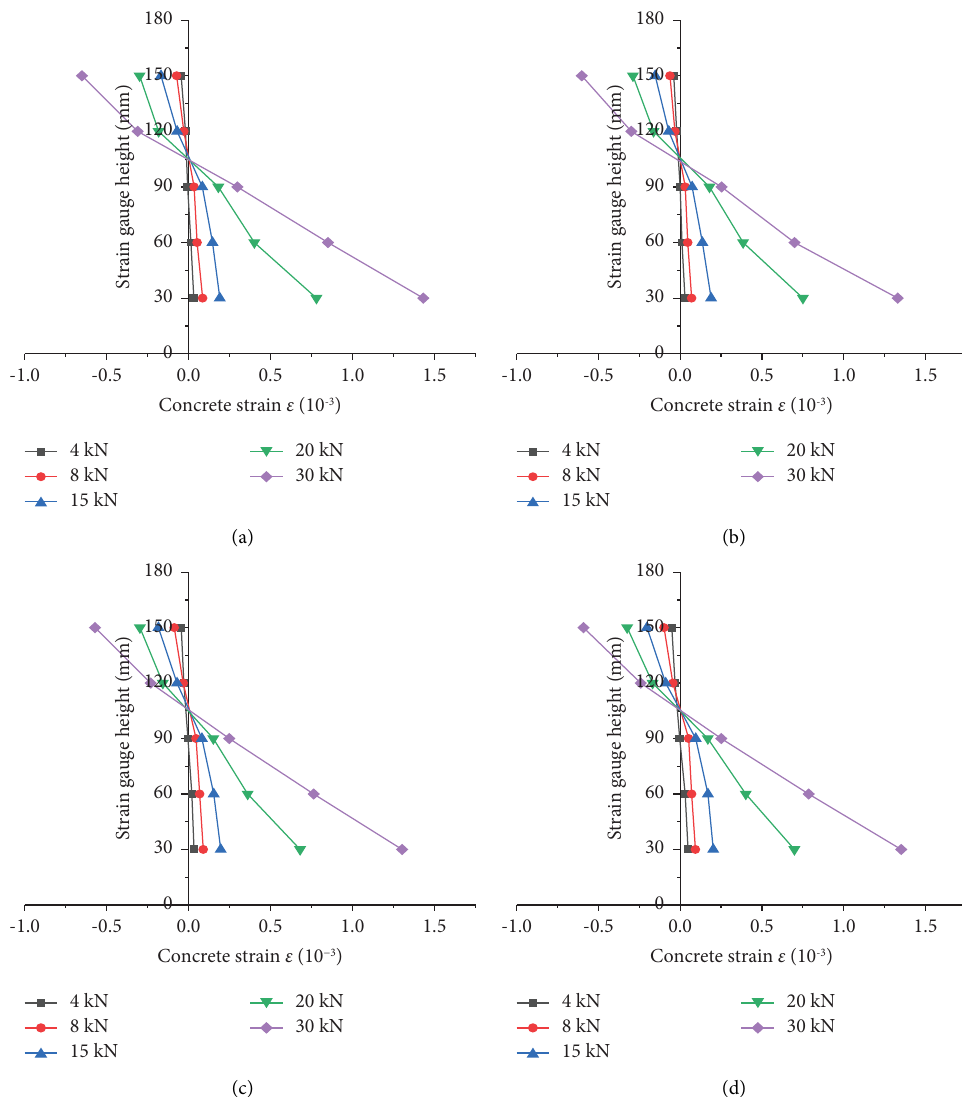
Figure 9: Strain distribution of diferent section heights in the middle of test beam in a chlorine environment. (a) CE-10; (b) CE-20; (c) CE- 30; and (d)